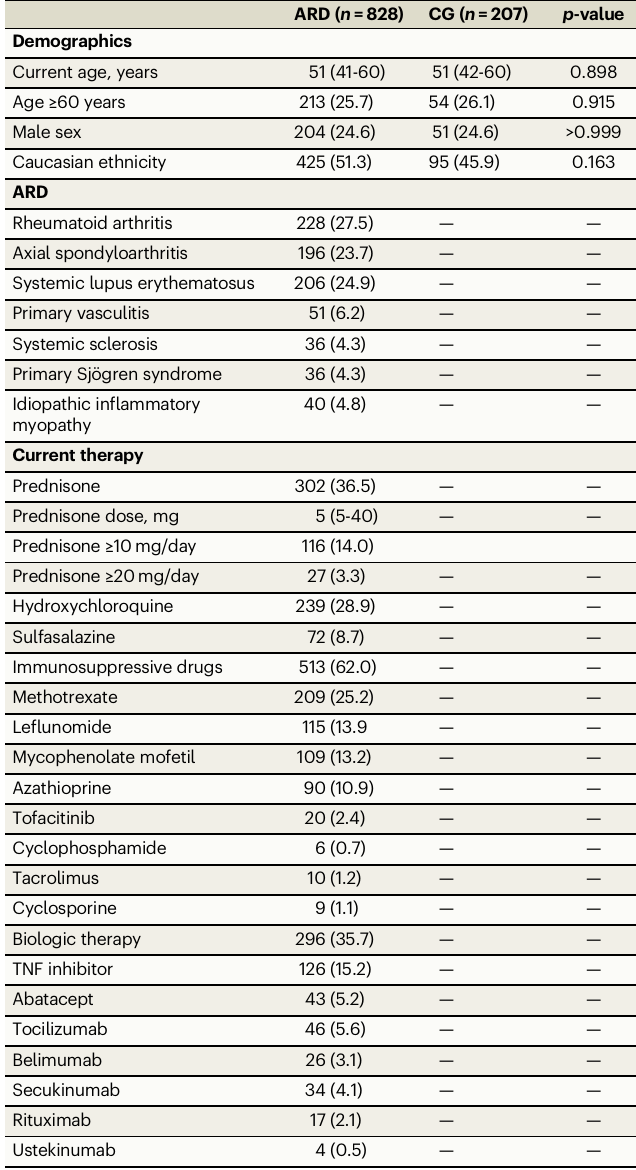
Table 1 | Characteristics of patients with ARD and CG at 6 weeks after second Sinovac-CoronaVac (D69)